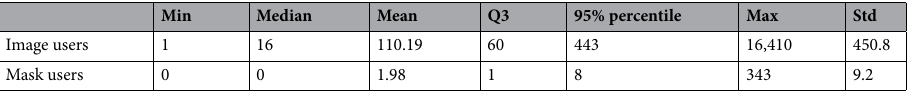
Table 2. Weekly number of users who posted images/mask-wearing images by county.